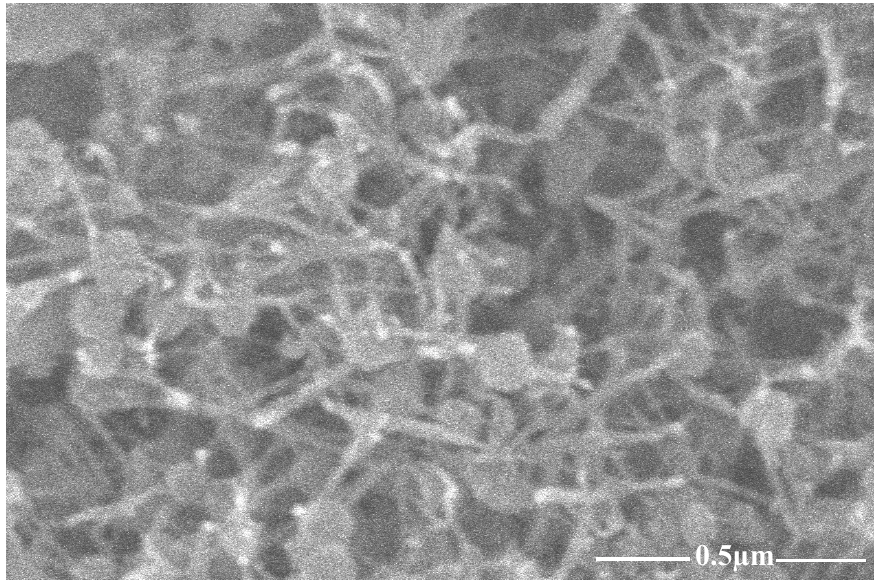
Figure 3. CNTs effect on surfactant. Figure 3. CNTs e ff ect on surfactant.